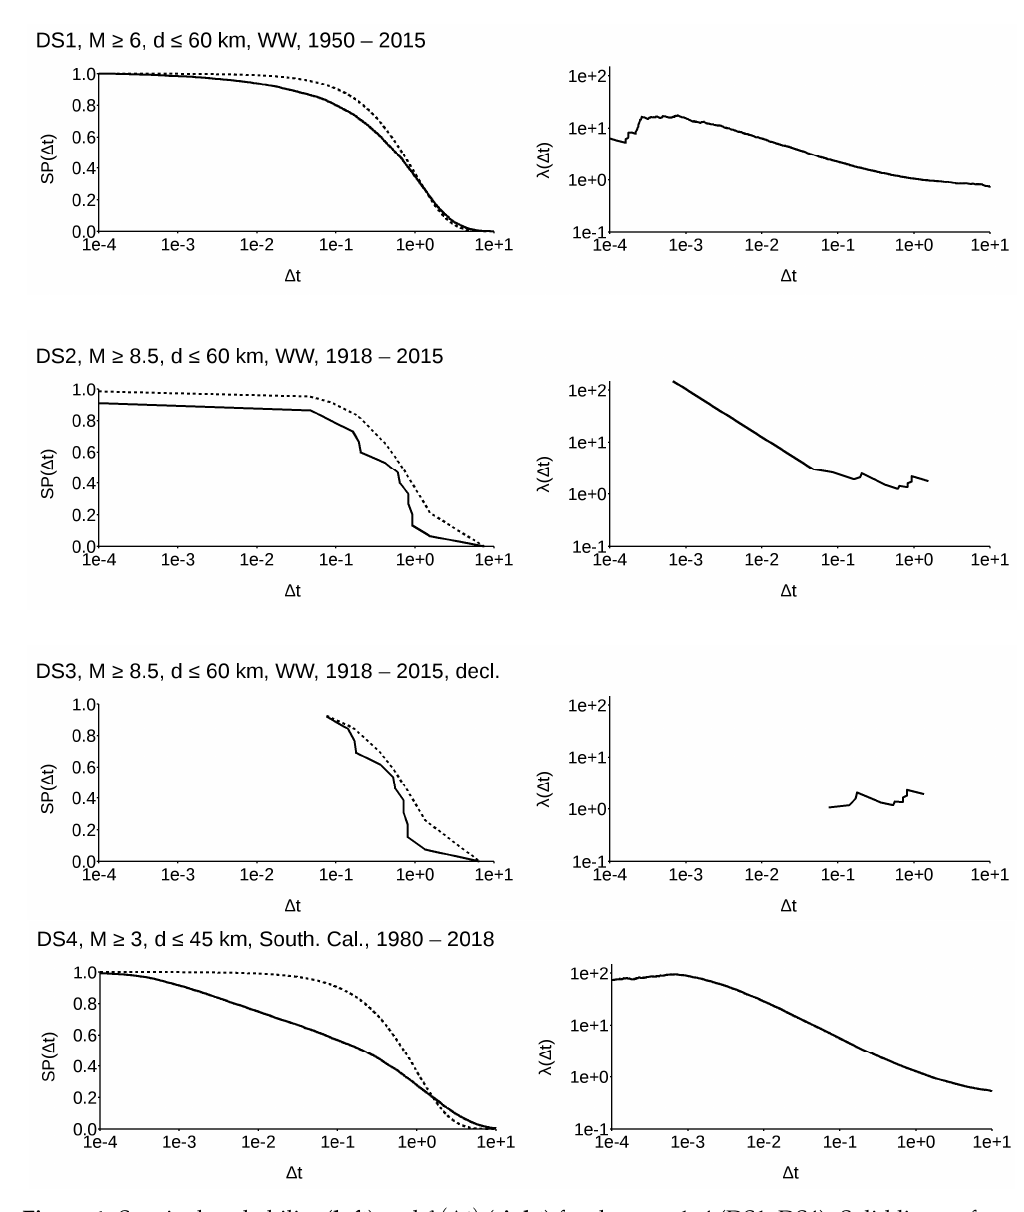
Figure 2. Distribution between earthquake triplets in DS1; abscissa: (cid:1986)(cid:1872) (cid:4670)(cid:3036),(cid:3036)(cid:2879)(cid:2869)(cid:4671) , ordinate: (cid:1986)(cid:1872) (cid:4670)(cid:3036)(cid:2878)(cid:2869),(cid:3036)(cid:4671) .